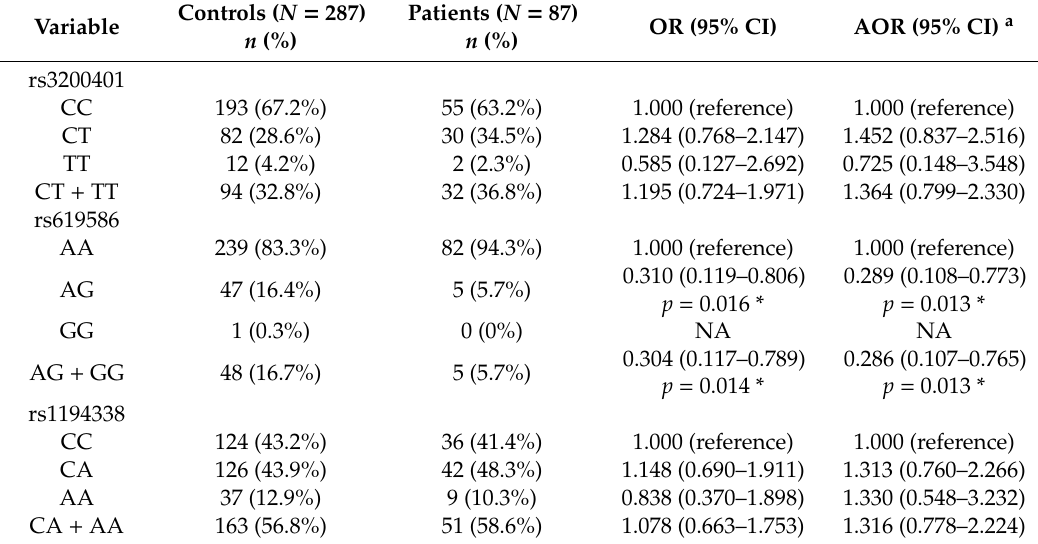
Table 3. Genotyping and allele frequency of MALAT1 single nucleotide polymorphisms (SNPs) in hepatocellular carcinoma and normal controls among those aged < 55